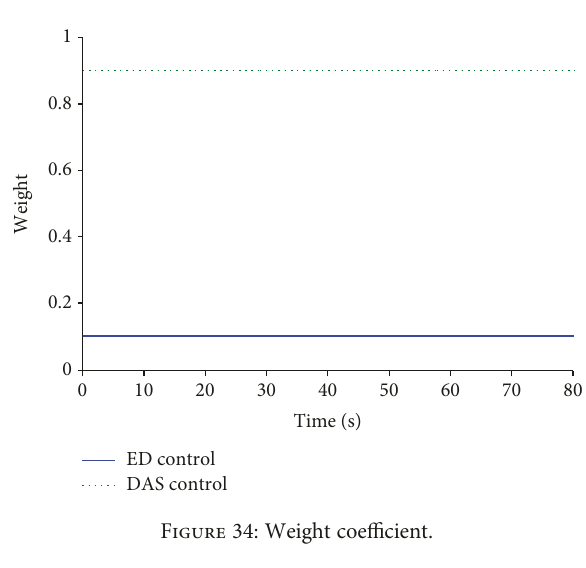
Figure 33: The control signal of in-wheel motors.